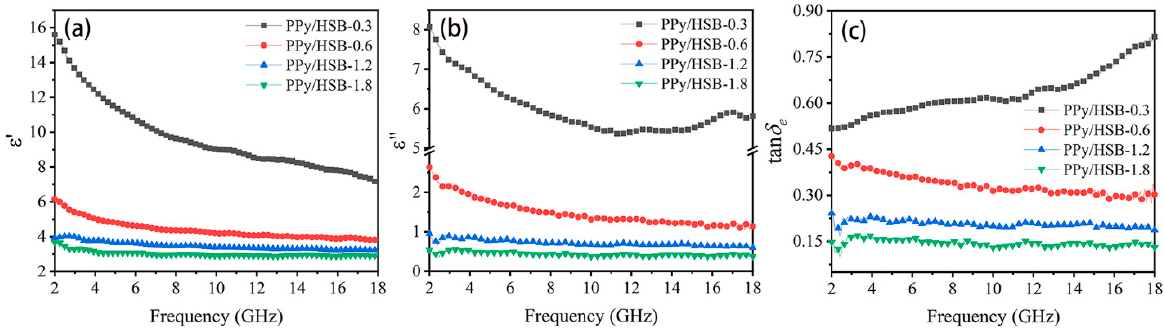
Figure 7. Real permittivity ( a ), imaginary permittivity ( b ) and dielectric loss ( c ) of the PPy/HSB composites.